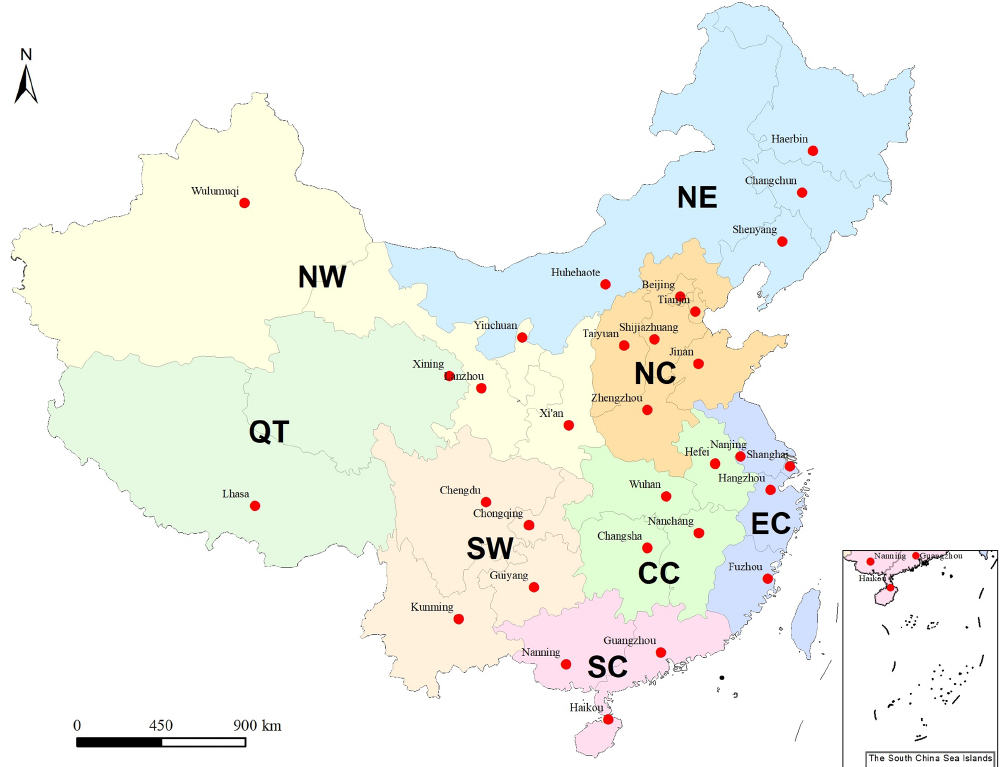
Figure 1. Distribution of the weather stations in 31 cities and climate zones in the study area (the climate zones include NE, NW, NC, CC, EC, SC, SW and